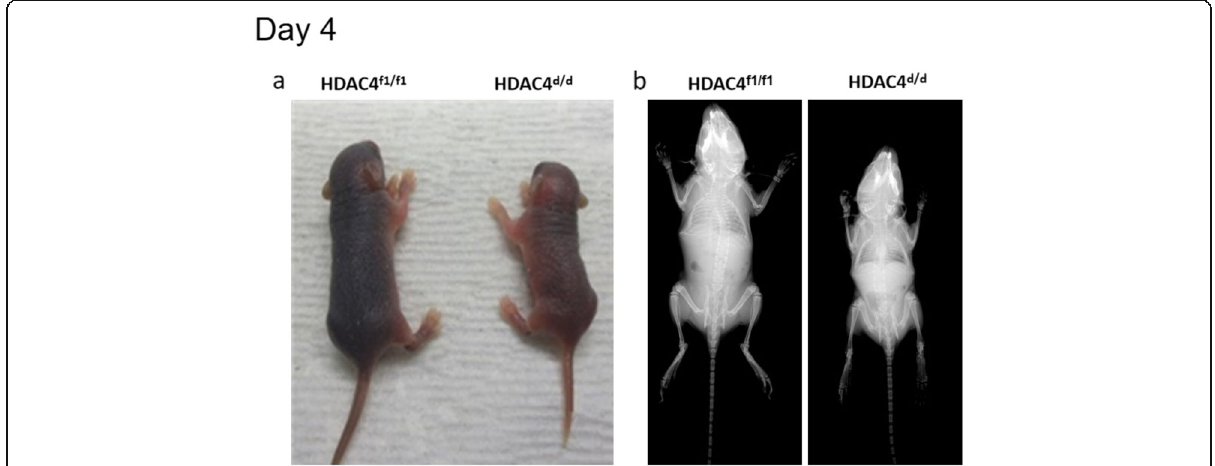
Fig. 1 Observations of smaller Col2 α 1-Cre; HDAC4 d/d pups. Photographs ( a ) and X-rays ( b ) of the Col2 α 1-Cre; HDAC4 d/d and HDAC4 f1/f1 pups